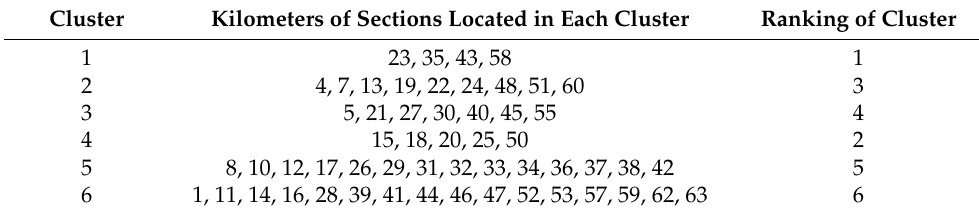
Table 2. Hotspot sections in each cluster. Cluster Kilometers of Sections Located in Each Cluster Ranking of